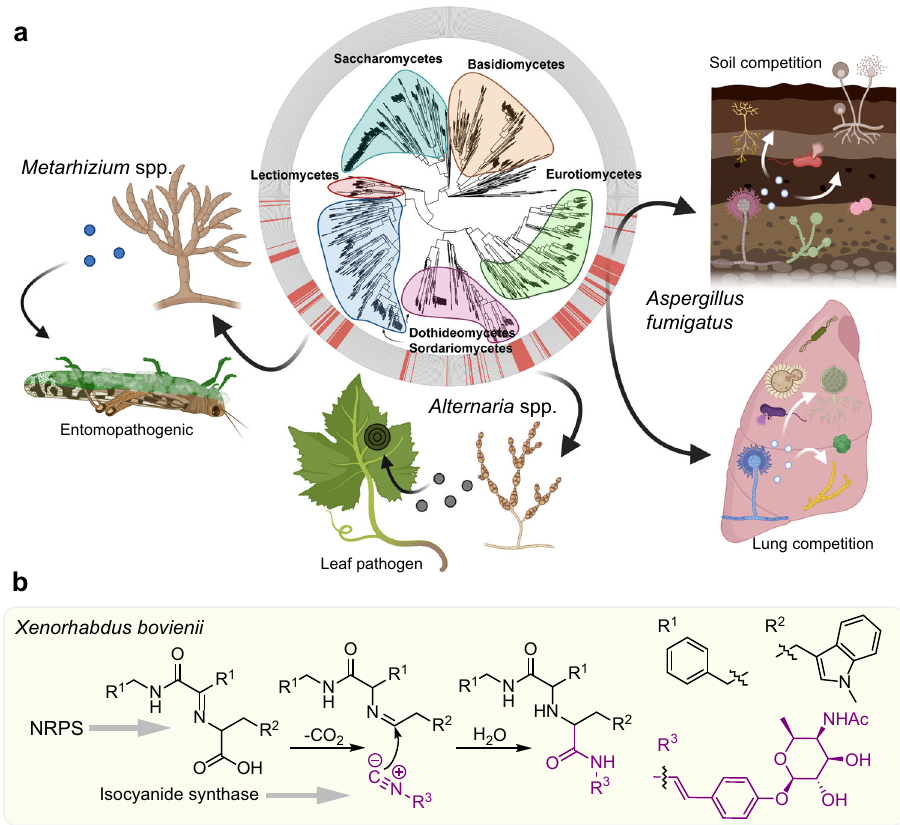
Fig.5|PhylogenetictreeandproposedfunctionsofCrmA-derivedmetabolites in fungal ecology. a CrmA proteins are found in three fungal taxa (for details, see Supplementary Data 1). CrmA is primarily found in pathogenic fungi including the insect pathogens Metarhizium, Cordyceps and Beauveria and the fungal parasite Trichoderma (Sordariomycetes),leafblightpathogens Bipolaris (e.g., Cochliobolus ) and Alternaria (Dothideomycetes) as well as in opportunistic pathogens and